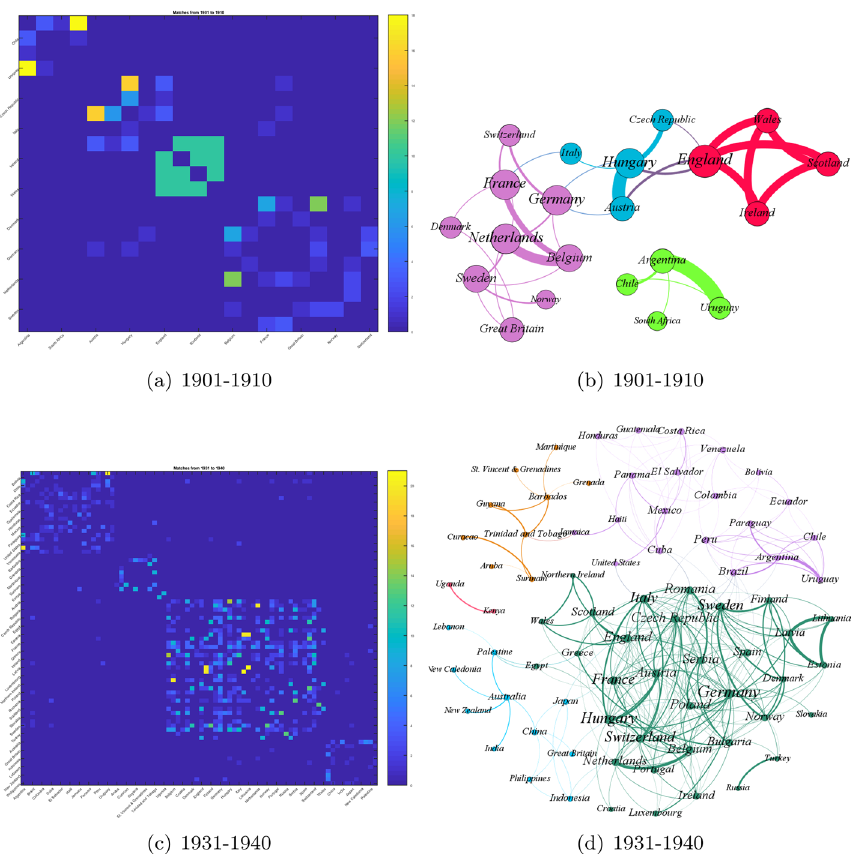
Fig. 10 Adjacency matrices and visualization for decade 1901-1910 and 1931-1940. Left: adjacency matrices. Right: network visualization. In ( b ) and ( d ), each color stands for one community. In early decades, boundaries between communities in the adjacency matrices as shown in ( a ) and ( c ) were not clear, and the correspondence between community assignment and confederation as shown in ( b ) and ( d ) was